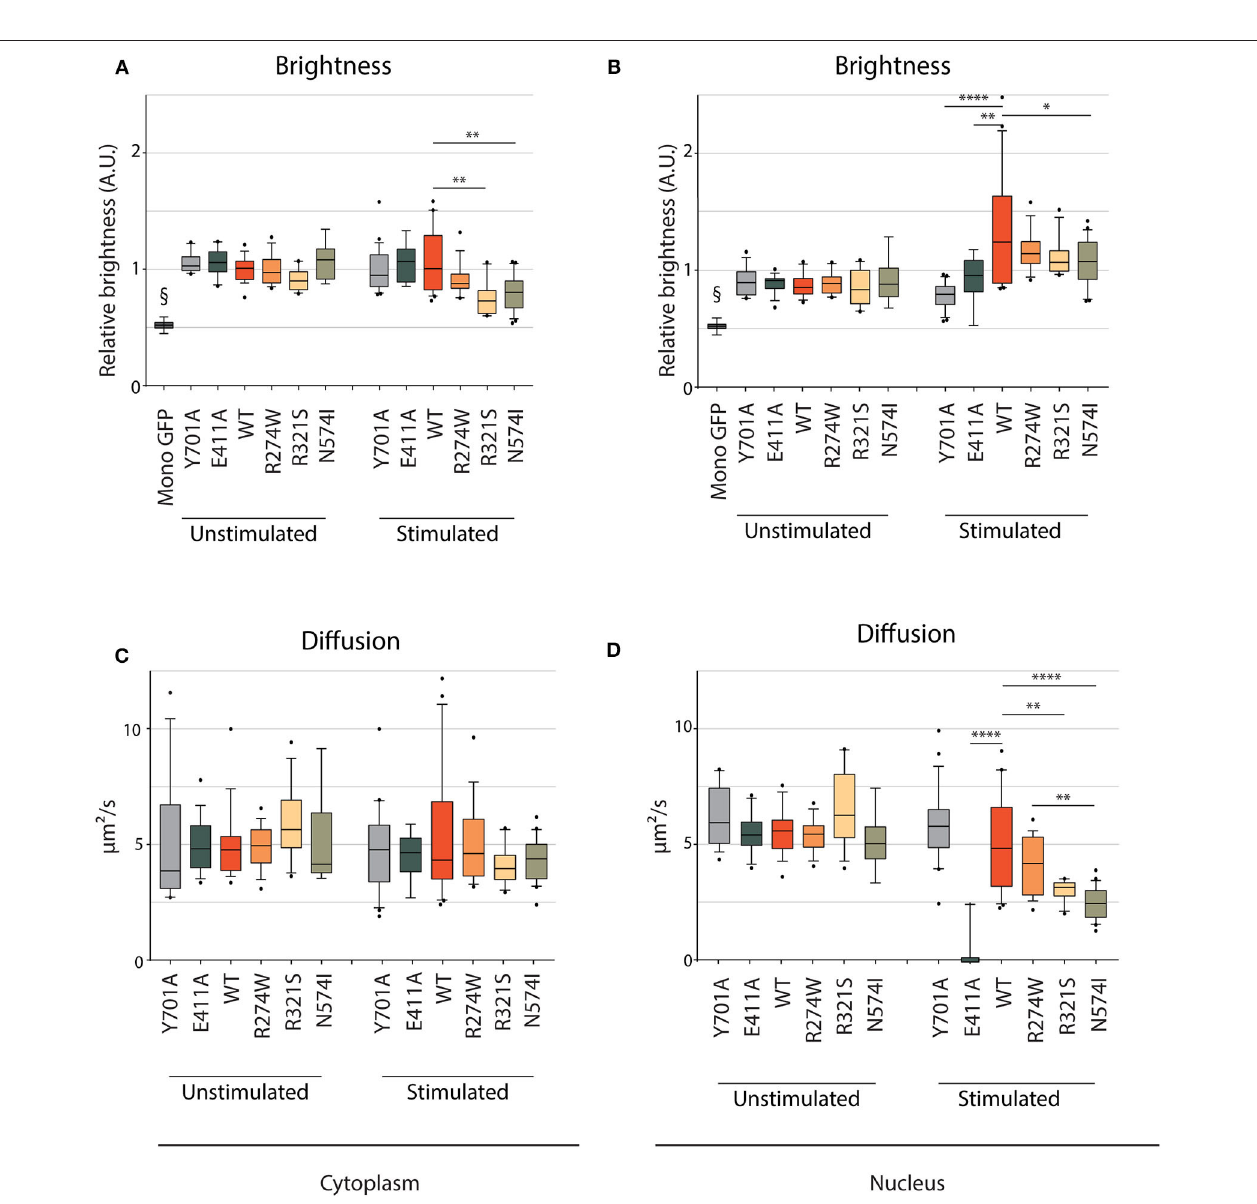
FIGURE 5 | RICS analysis of STAT1-GFP WT and GOF mutations in U3A cells. Brightness (A,B) and average diffusion constant as a marker of mobility (C,D) measurement of cytoplasmic and nuclear STAT1-GFP fusions in unstimulated U3A cells and cells stimulated with IFN γ (1 U/ µ l). §GFP monomers, measured in HEK cells. Brightness is expressed in arbitrary units and plotted as fold increase compared to cytoplasmic WT. Data in panels (A–D) ( n > 7) are represented in box and whiskers plots. The central line represents the median, while the box extends from the 25th to 75th percentiles with whiskers spanning 10–90% intervals. Dots outside these intervals are represented as single dots. Statistical analysis: One-way ANOVA with Tukey’s post-hoc test. * P < 0.05 ; ** P < 0.01 ; **** P < 0.0001.